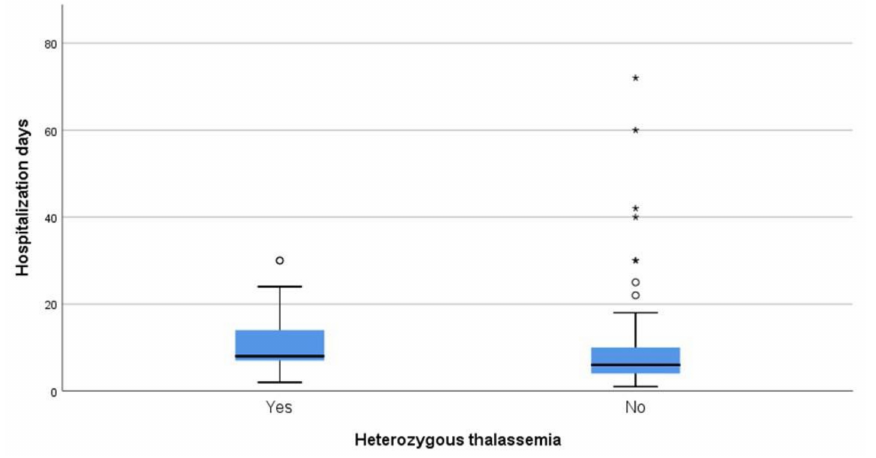
Figure 4. Days of hospitalization between carries and non-carriers that